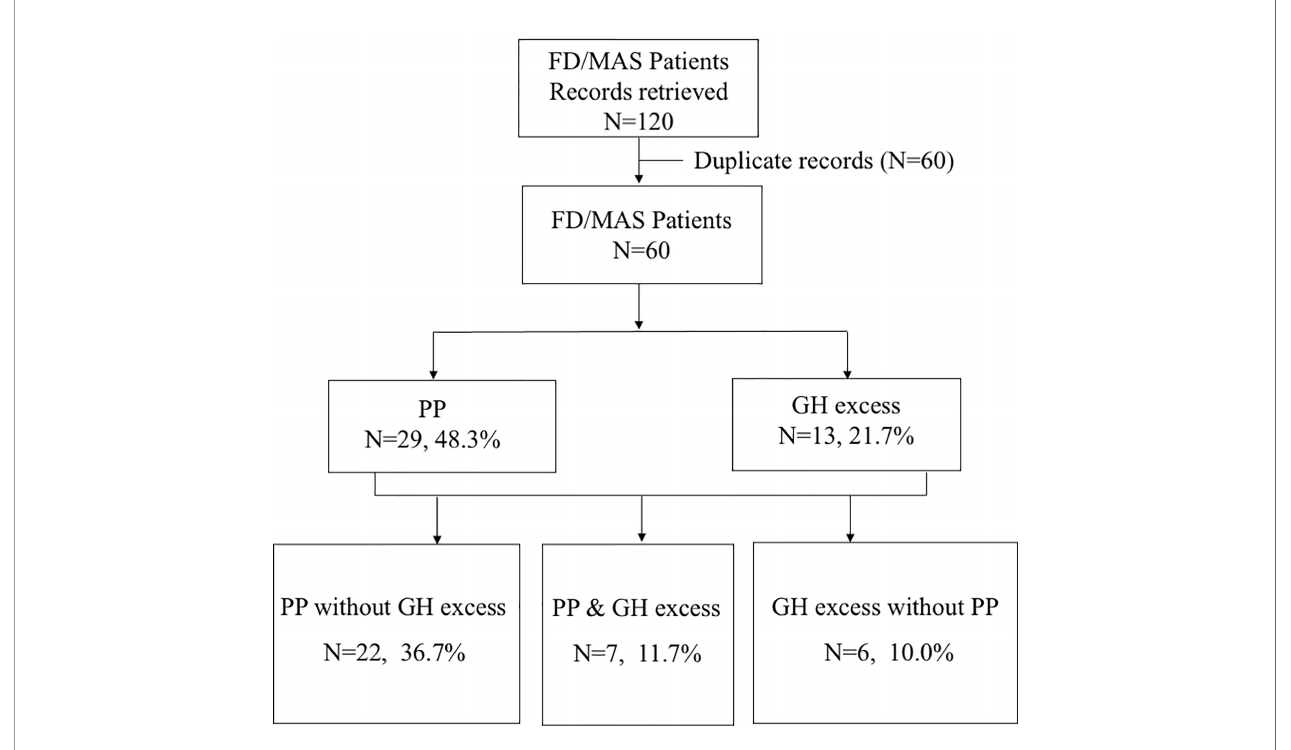
FIGURE 1 | Flowchart of the study